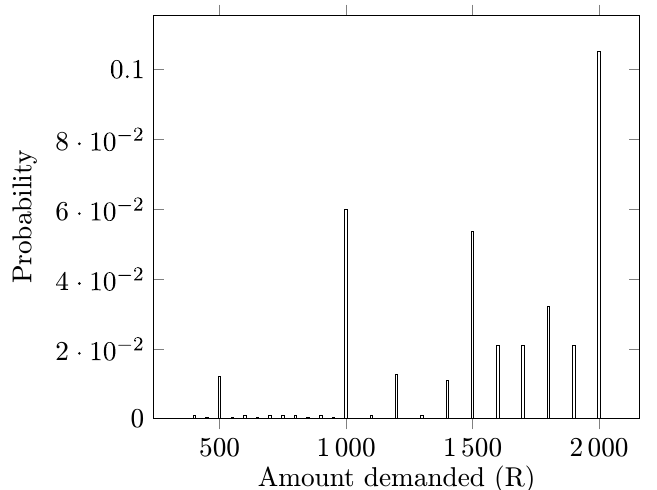
Figure 3: An example of the demand distribution for an